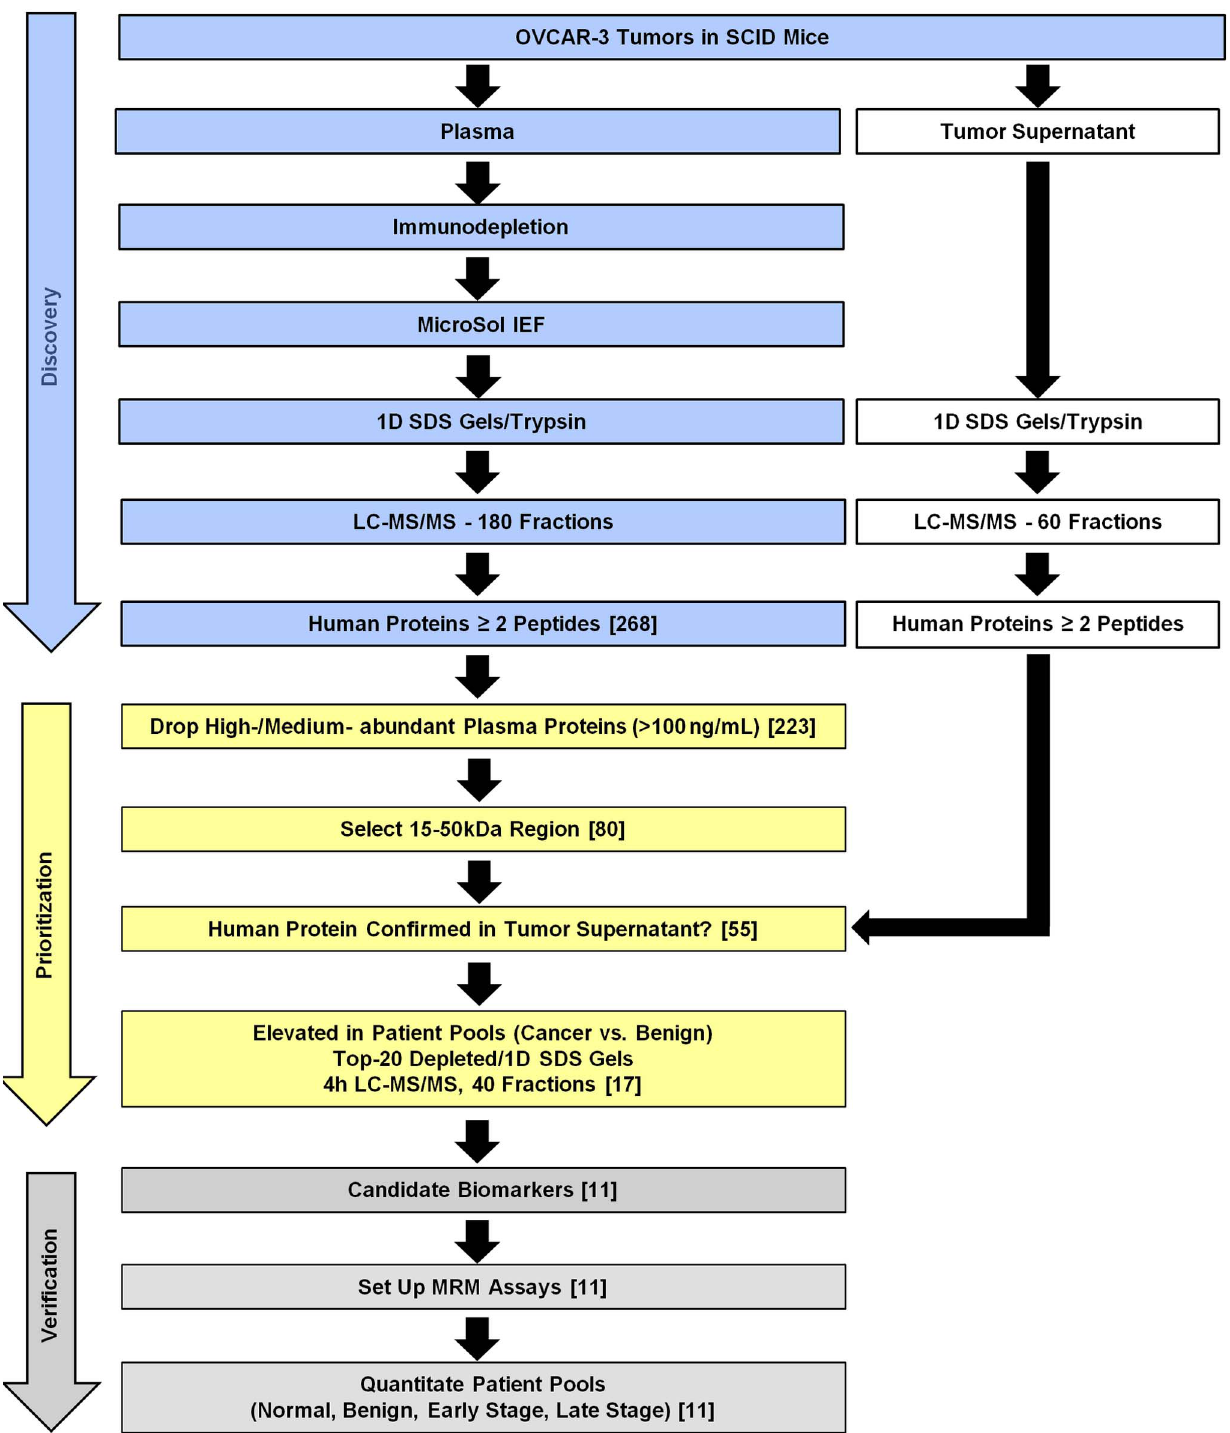
Figure 1. Scheme for ovarian cancer biomarker discovery and efficient verification using a xenograft mouse model. Candidate biomarkers were discovered in the xenograft mouse plasma using a 4D plasma proteome profiling method. Parallel analysis of the tumor supernatant was used to confirm human protein identifications and expand sequence coverage. A multi-step prioritization method ensured that only those proteins detectable in advanced EOC patient sera at elevated levels advanced to MRM assay development and verification in larger pools of patient sera.